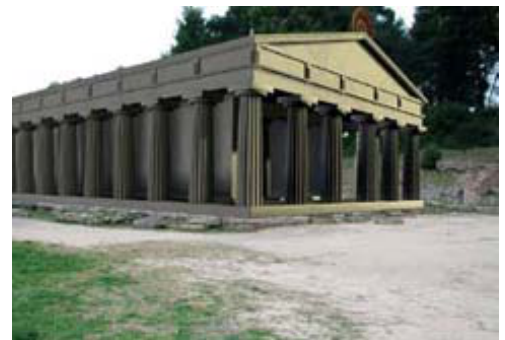
Figure 1. Arheoguide system (Vassilios, 2001)